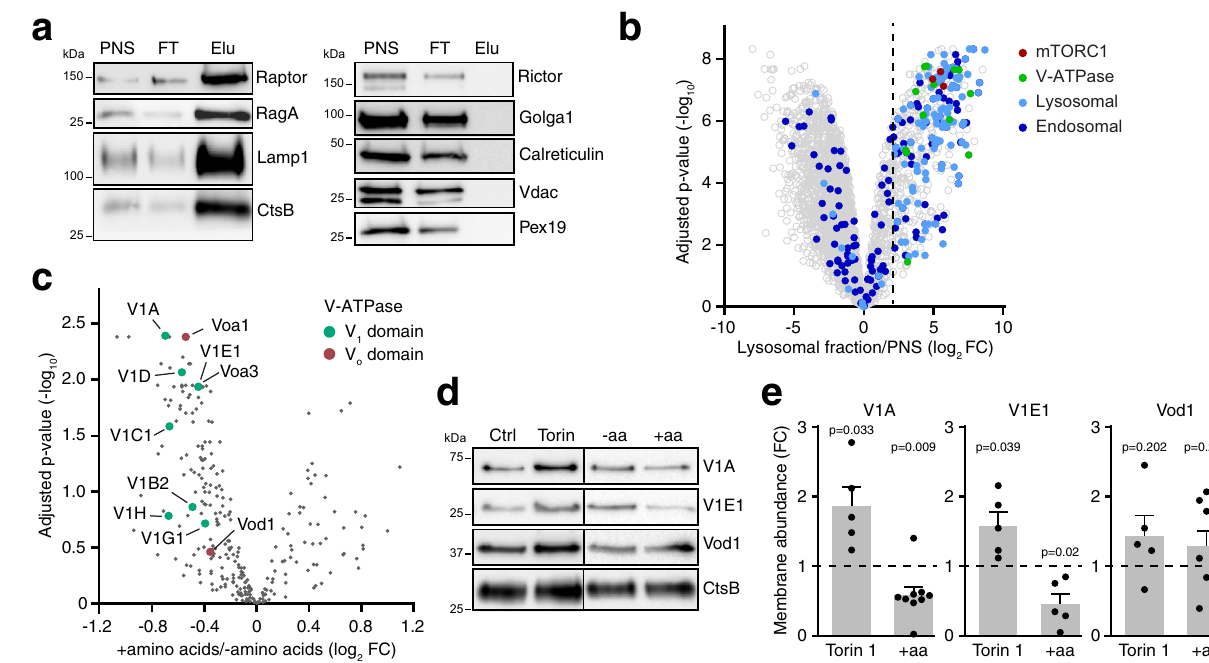
Fig. 3 | Lysosomal V-ATPase increases in response to mTORC1 inactivation. a Magnetic enrichment of lysosomes from MEFs, analysed by western blot. PNS: post nuclear supernatant; FT: column fl ow through; Elu: lysosomal eluate. Con- taminating organelle markers are Golga1 (Golgi), Calreticulin (ER), Vdac (mito- chondria), Pex19 (peroxisomes). b Enriched proteins in lysosomal fractions, quanti fi ed by label-free mass spectrometry. The dashed line (log 2 fold change >2) demarcates the cut-off for lysosomal proteins. c Changes in lysosomal proteins after 1h aa starvation+30min aa restimulation (+aa) versus 1h aa starvation ( − aa) in MEFs, quanti fi ed by label-free mass spectrometry. d V-ATPase subunits in membrane fractions of dextran-loaded lysosomes from MEFs after 1h±torin 1